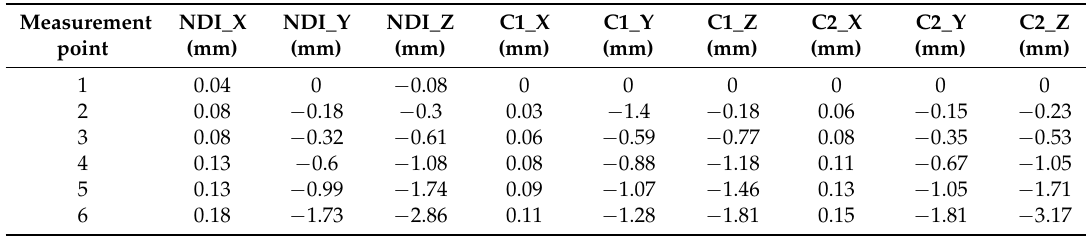
Table 10. Deformation displacement by NDI measurement and reconstruction with the C1 and C2 scheme in marker point for slight load